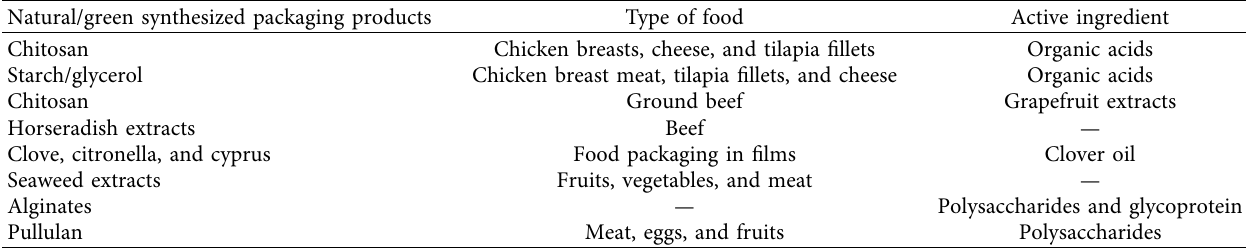
Table 2: Natural/green synthesized active packaging [16, 17].